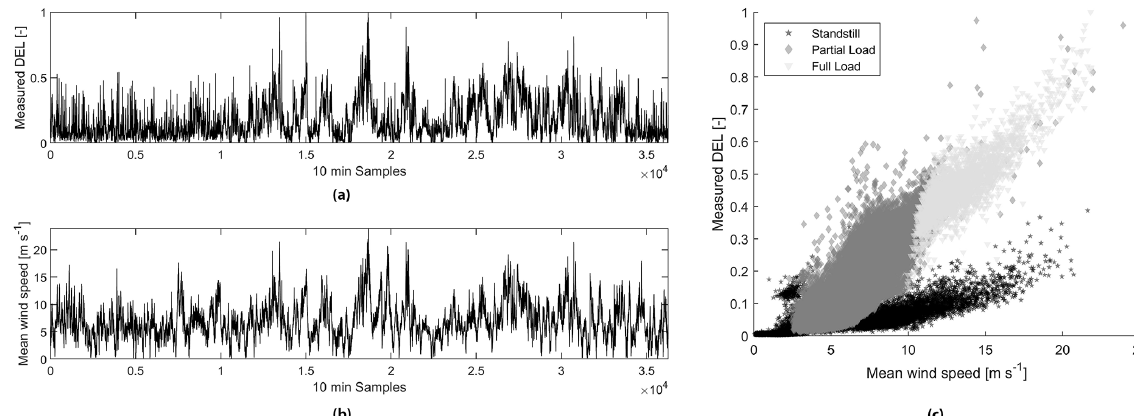
Figure 2. Time series corresponding to (a) normalized measured DELs, (b) mean wind speed, and (c) scatterplot of both mean wind speed and measured DELs with a correlation coefficient of 0.74 when data are not filtered by operational modes.